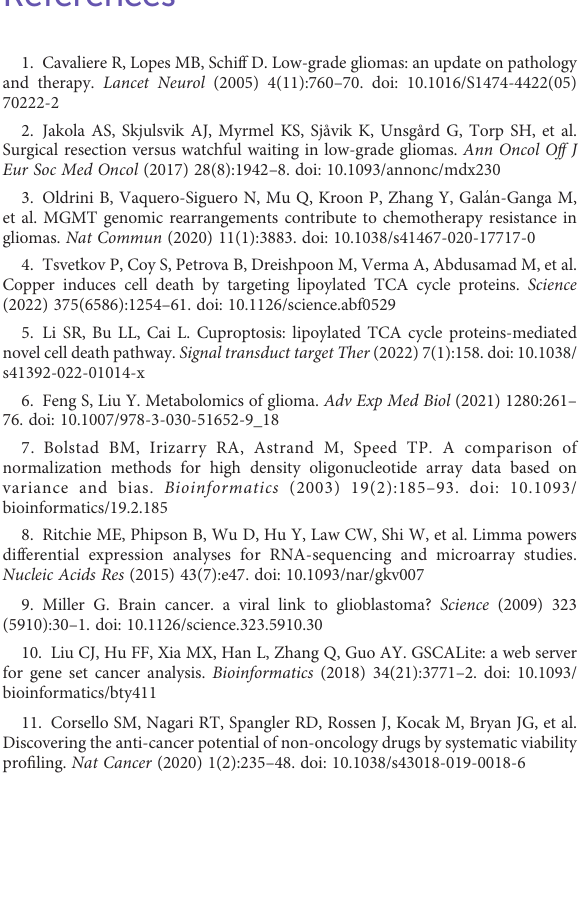
SUPPLEMENTARY FIGURE 2 Correlation between CARS and tumor-in fi ltrating immune